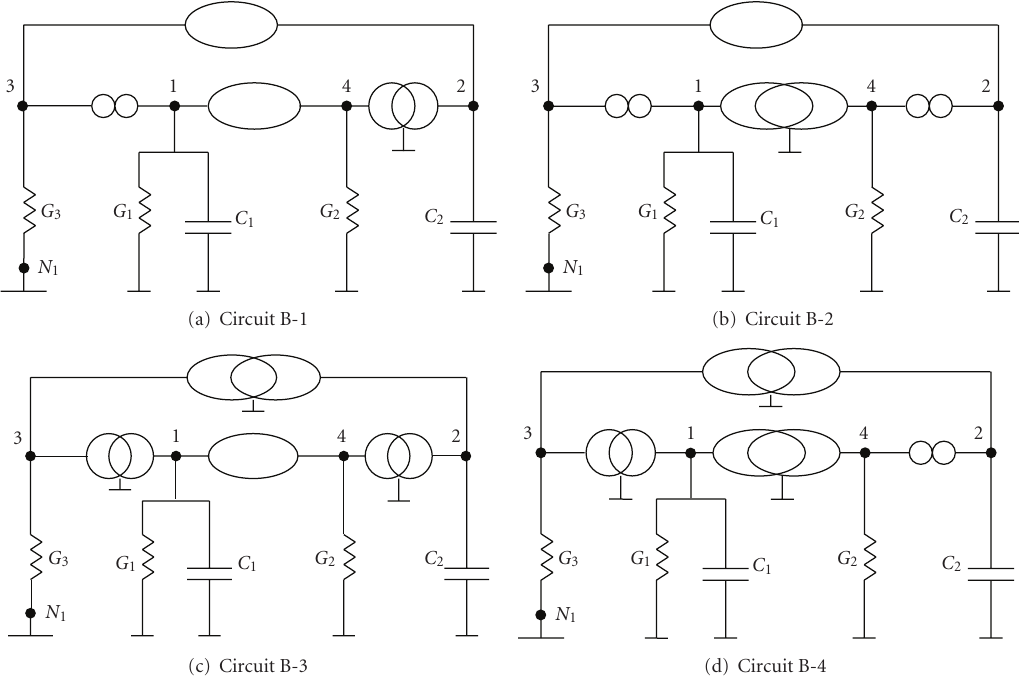
Figure 4: Realizations of type-B two integrator loop